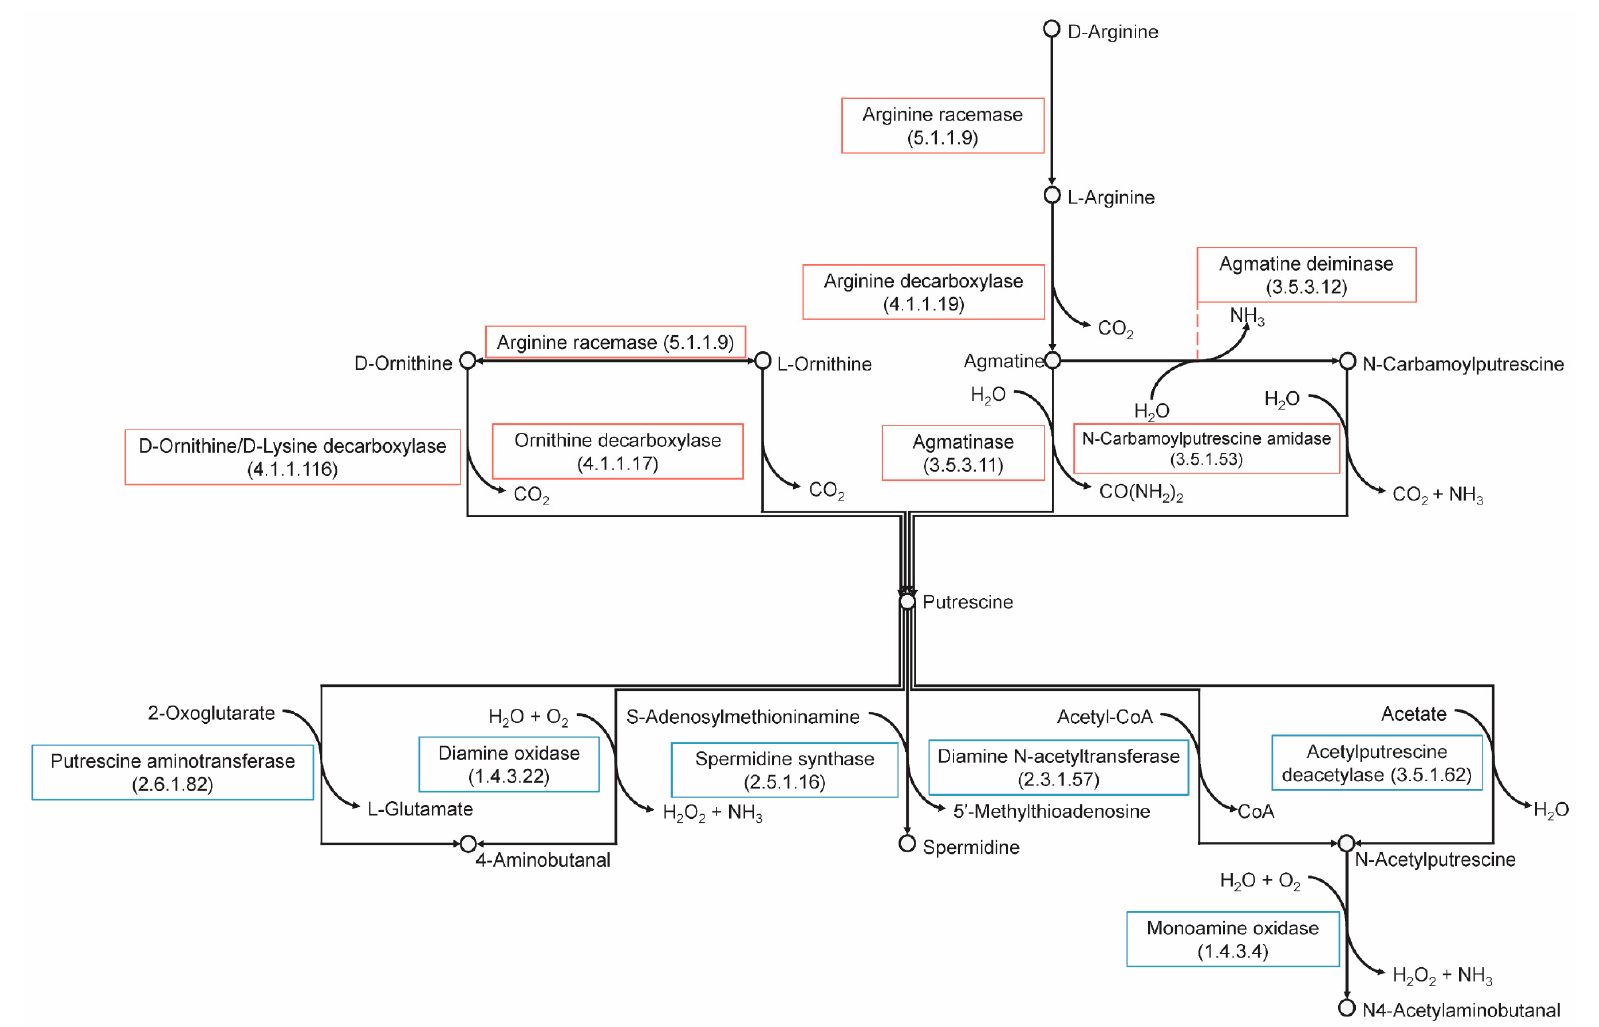
Figure 4. Metabolic pathways for the synthesis and degradation of putrescine.